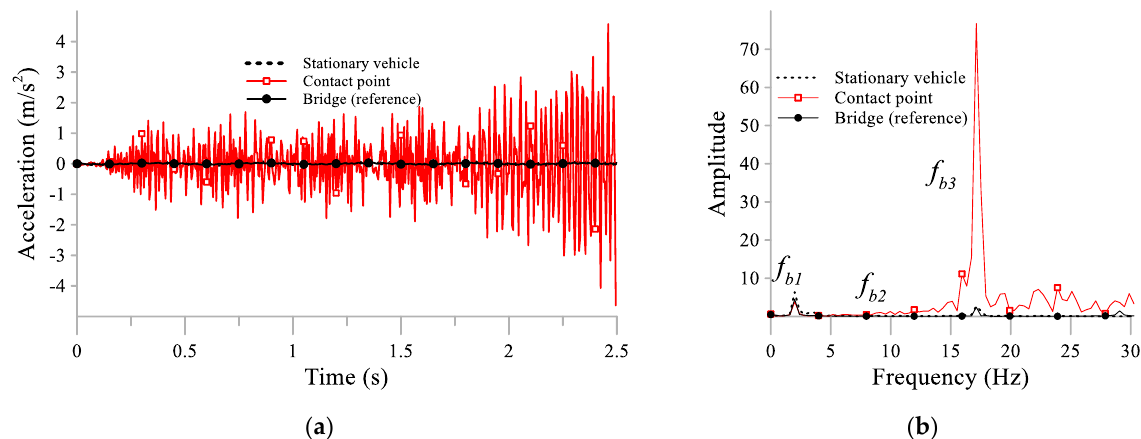
Figure 17. Road roughness effects on the damped stationary vehicle and its contact-point and bridge ( a ) acceleration response at the mid-span location, along with ( b ) the acceleration spectra.